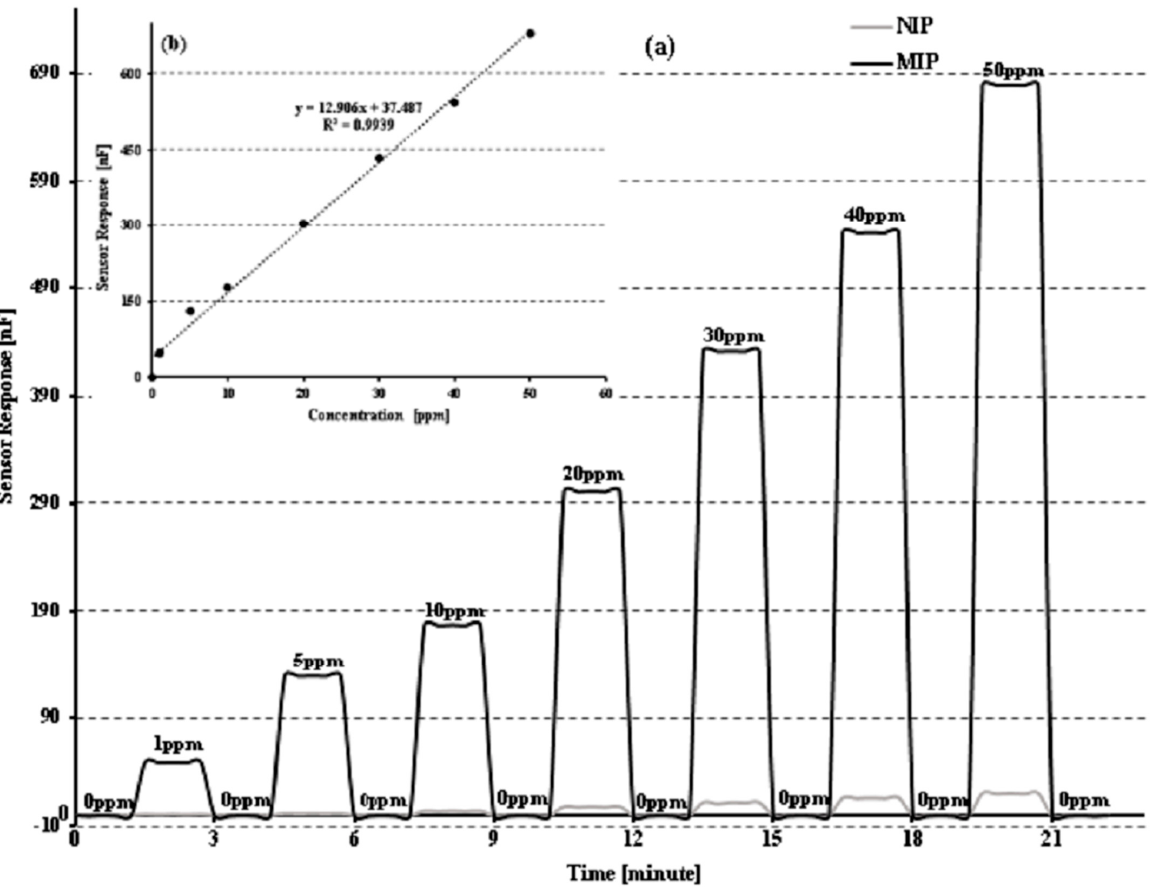
Figure 5. ( a ) Sensitivity response of MIPs and NIPs of polyurethane-based sucrose sensor at dif- ferent concentrations (0–50 ppm); ( b ) linear regression analysis of sucrose sensor. concentrations (0–50 ppm); ( b ) linear regression analysis of sucrose